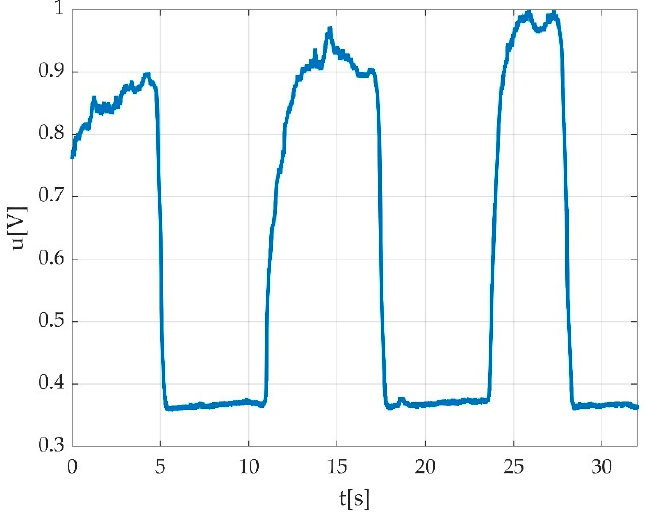
Figure 17. Example of measurement with non-uniform time interval during MVIC, the longer contraction time (third MVIC).